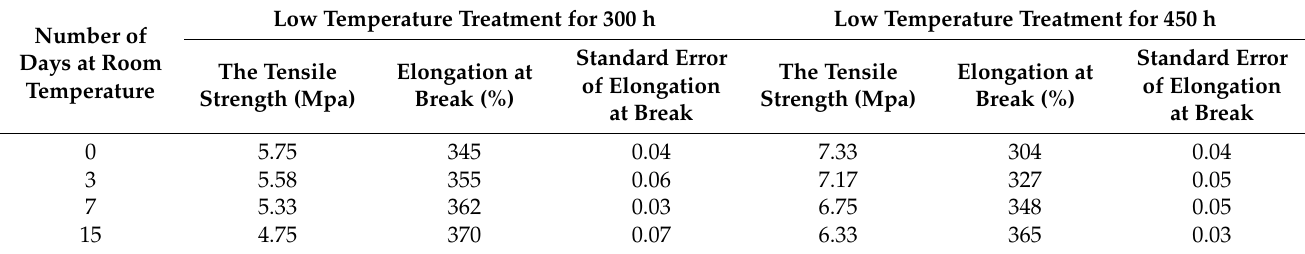
Table 5. Data of tensile properties recovery of fluorosilicone rubber samples.